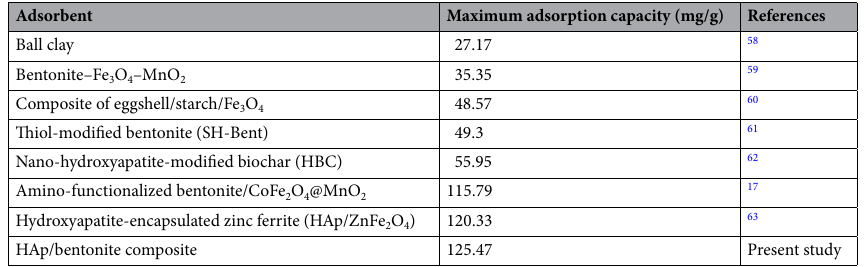
Table 7. Comparison of maximum adsorption capacities of various adsorbents towards Cd(II).